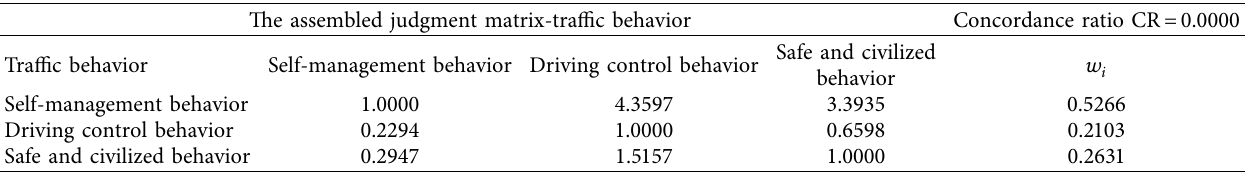
Table 6: Discriminant matrix of traffic behavior secondary indicators and